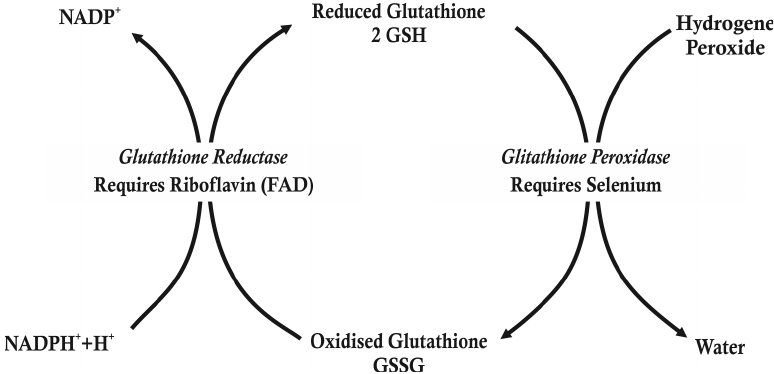
Figure 4. The role of selenium against the enzyme glutathione peroxidase (Fang,